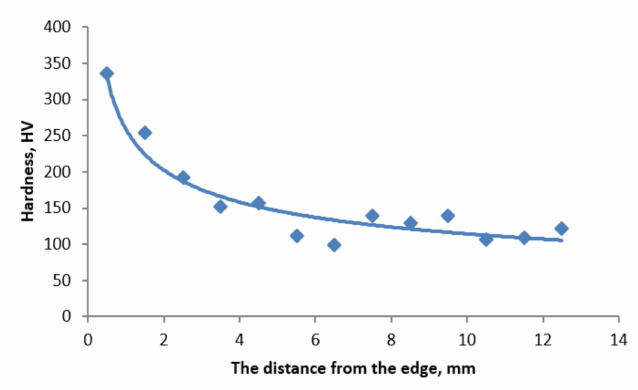
Figure 17. Change of hardness at a distance from the working